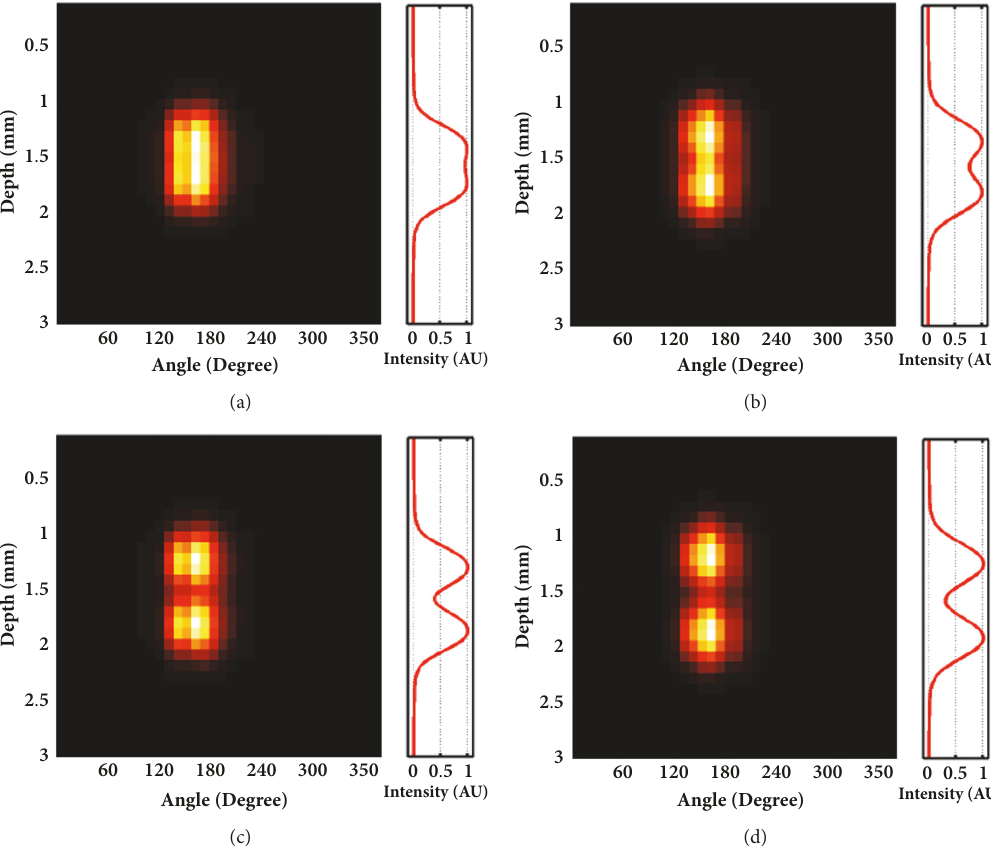
Figure 6: Results from a simulation to find the resolution of our proposed system. Based on this result, when the particles are positioned at the distance of 0.5 mm from the fiber tip, the particles are still detectable as two separate particles and the vertical distance between them is larger than 0.49 mm .